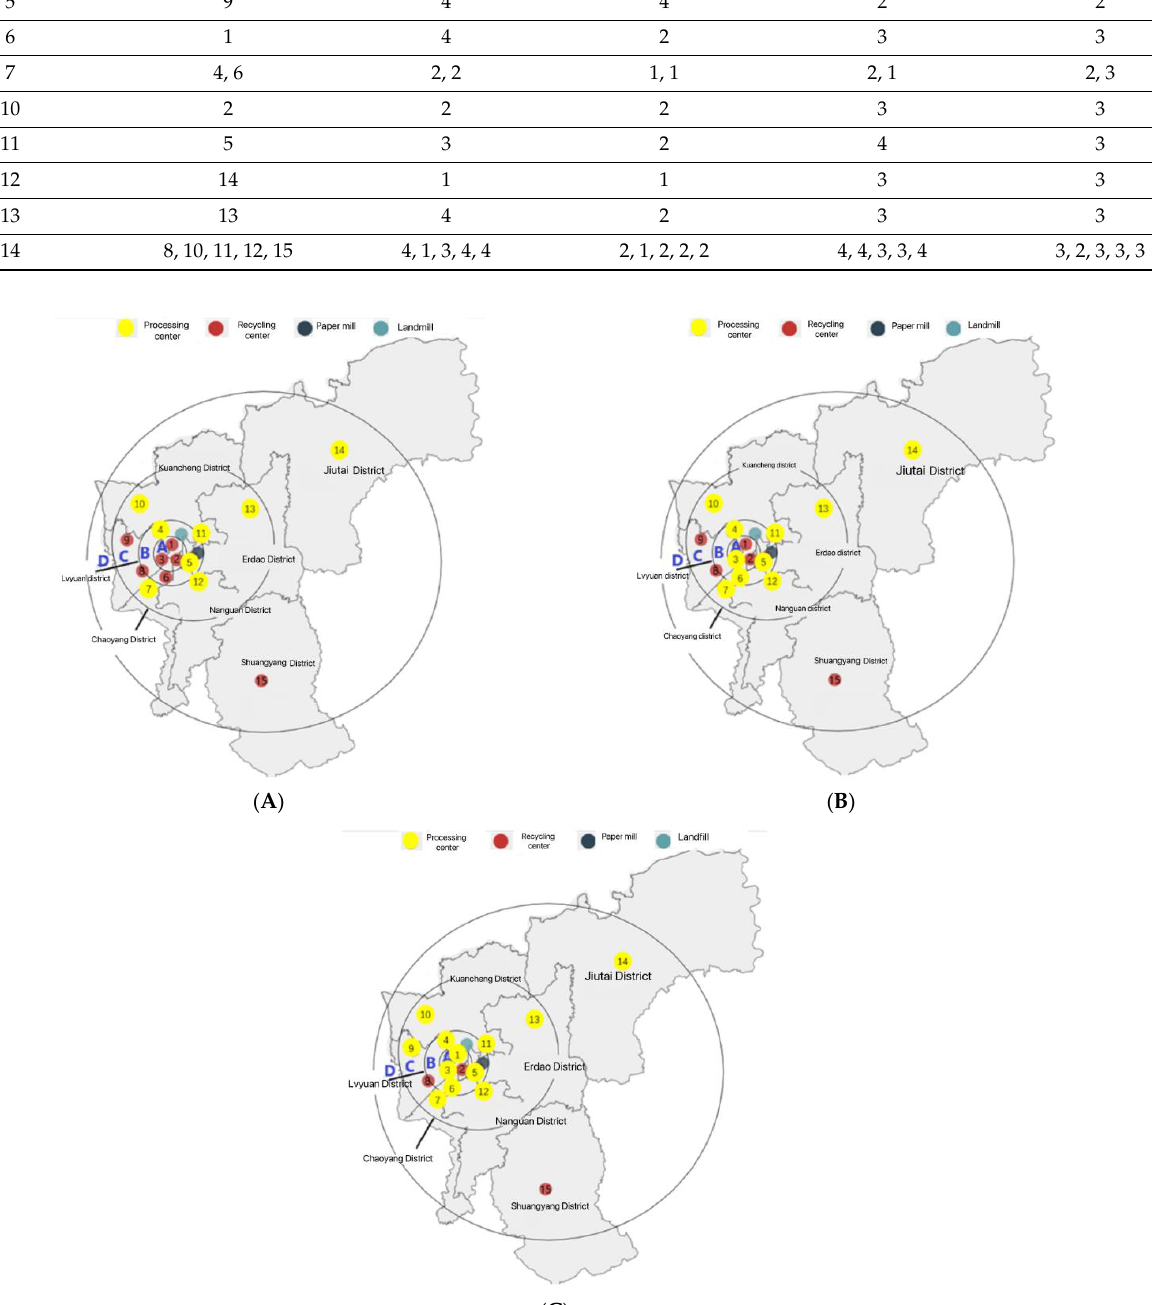
Figure 18. ( A ) Schematic diagram of the location of each node of the class I sample solution. ( B ) Schematic diagram of the location of each node of the class II sample solution. ( C ) Location diagram of nodes of Class III sample solutions.